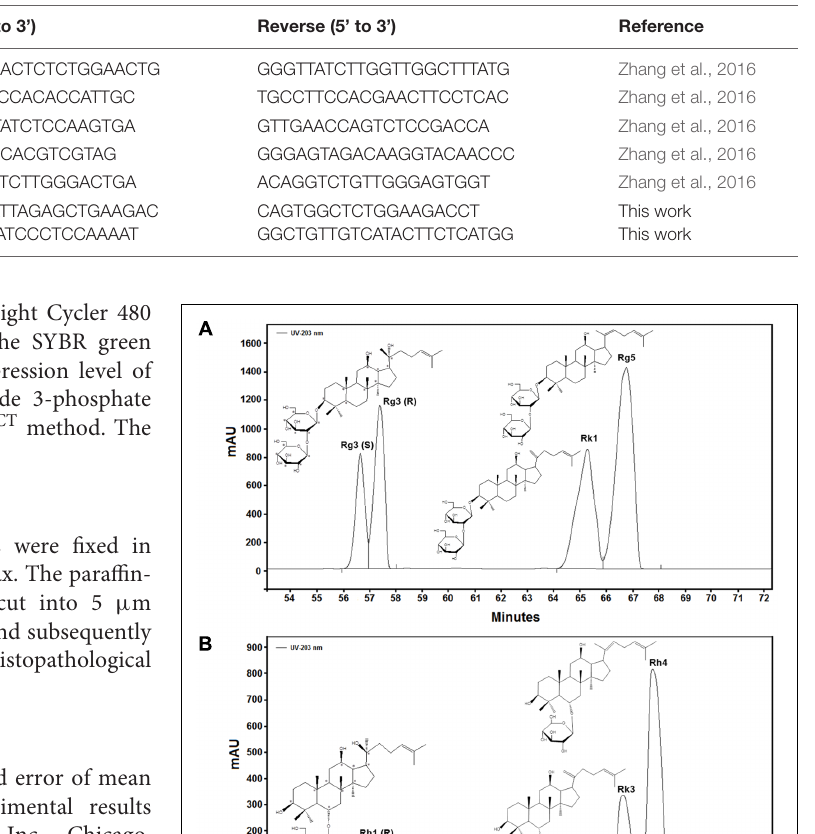
TABLE 1 | The primer sequences were used for qPCR in this study.